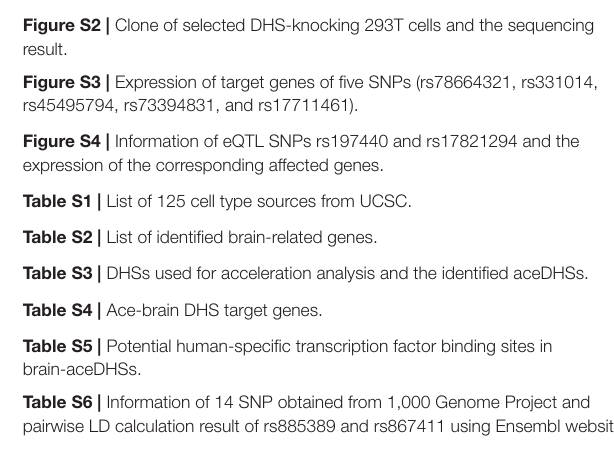
Figure S1 | Proportions of DHSs under accelerated evolution contributions (DHSs under accelerated evolution vs. total DHSs selected for analysis). Figure S2 | Clone of selected DHS-knocking 293T cells and the sequencing result.